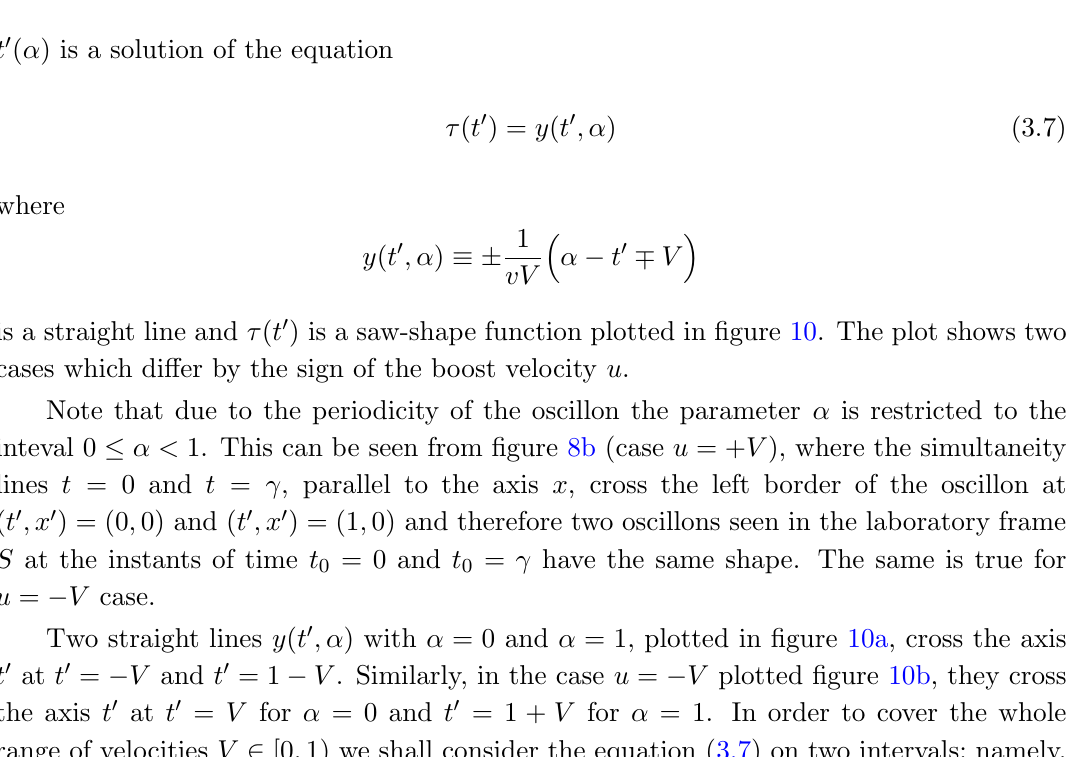
Figure 10 . Functions (cid:28) ( t 0 ) and y ( t 0 ; (cid:11) ) for V = 0 : 5 and v = 0 : 3 (here V > V c = 10 dashed line represents solution of equation (3.7) with certain (cid:11) ; here (cid:11) = 0 :